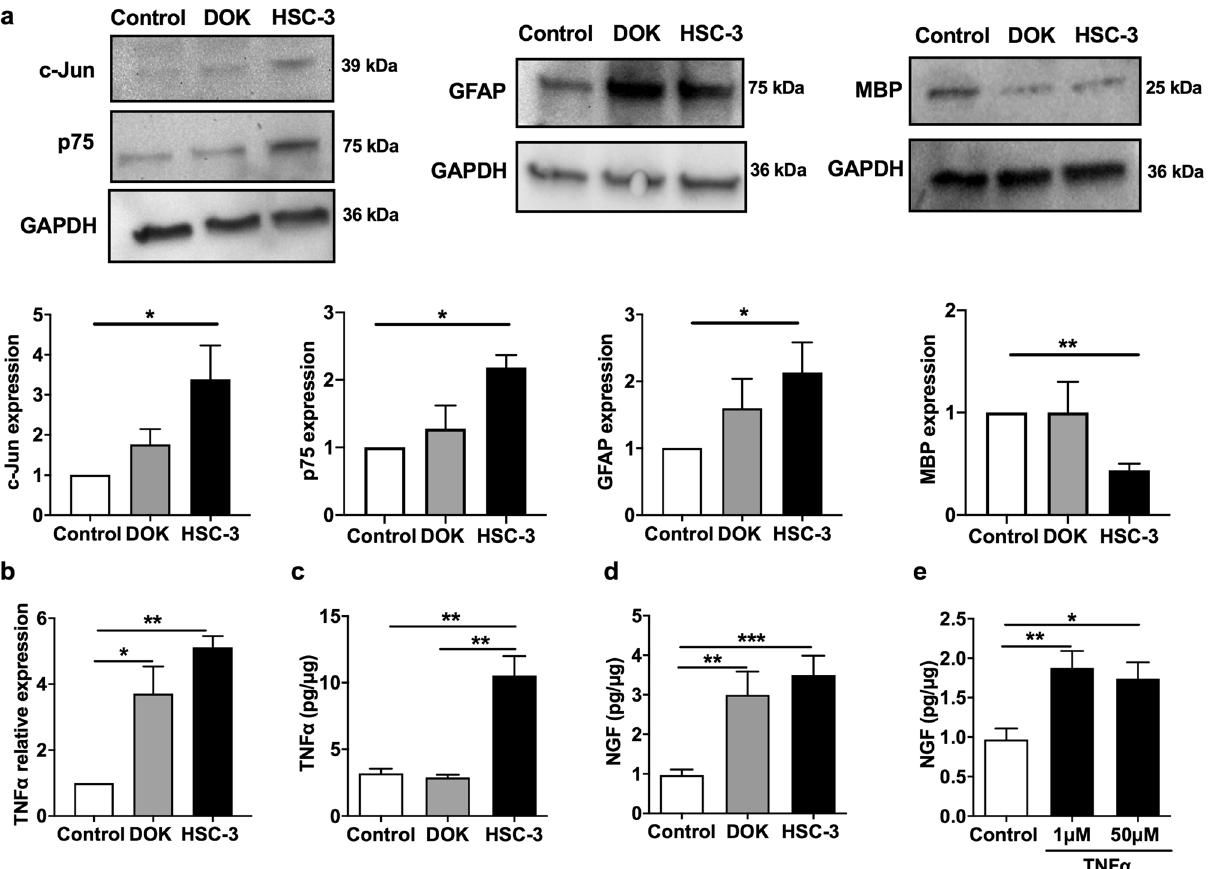
Figure 6. Activated Schwann cells release increased NGF and TNFα. ( a ) Schwann cells co-cultured with HSC-3 cells overexpressed c-Jun, GFAP, p75 but downregulated MBP compared to control Schwann cells (media alone). Full-length gel blots were provided in Supplemental Fig. S2 online. ( b ) Both DOK and HSC-3 co-cultures increased TNFα mRNA expression in Schwann cells compared to control Schwann cells. ( c ) TNFα protein concentration in Schwann cells co-cultured with either DOK or HSC-3 cells compared to control Schwann cells. ( d ) HSC-3 cell or DRK co-culture increased NGF release in Schwann cells compared with control Schwann cells. ( e ) Adding TNFα in cell culture media stimulated increased NGF release compared with control Schwann cells. One-way ANOVA. * P < 0.05; ** P < 0.01; *** P <